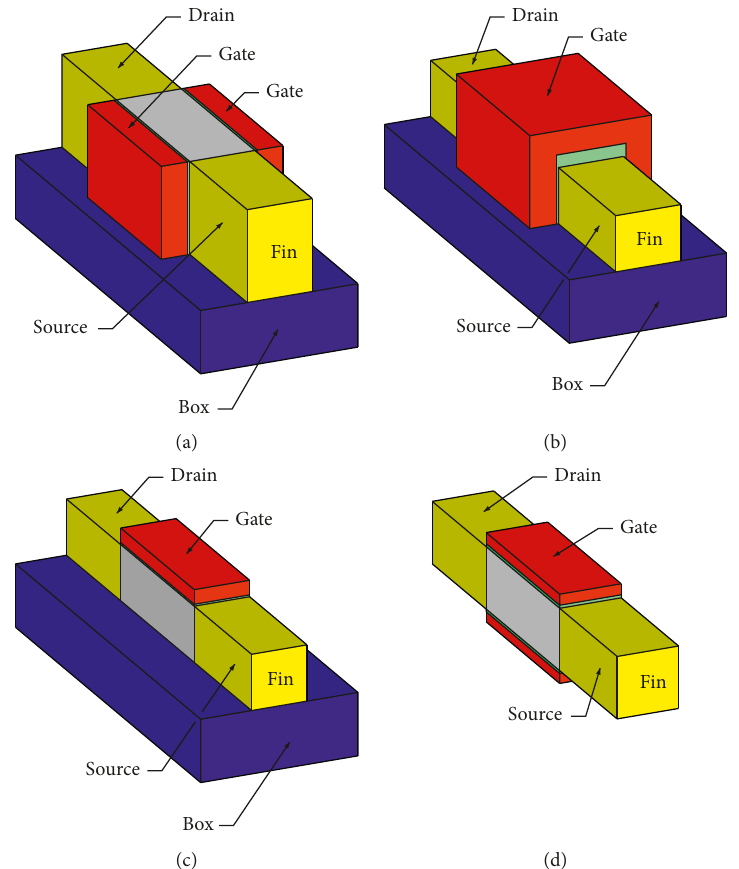
Figure 1: Different types of SOI devices: (a) independent double-gate FinFET on SOI, (b) double-gate nonplanar FinFET (common gate FinFET), (c) single-gate SOI transistor, and (d) double-gate planar SOI